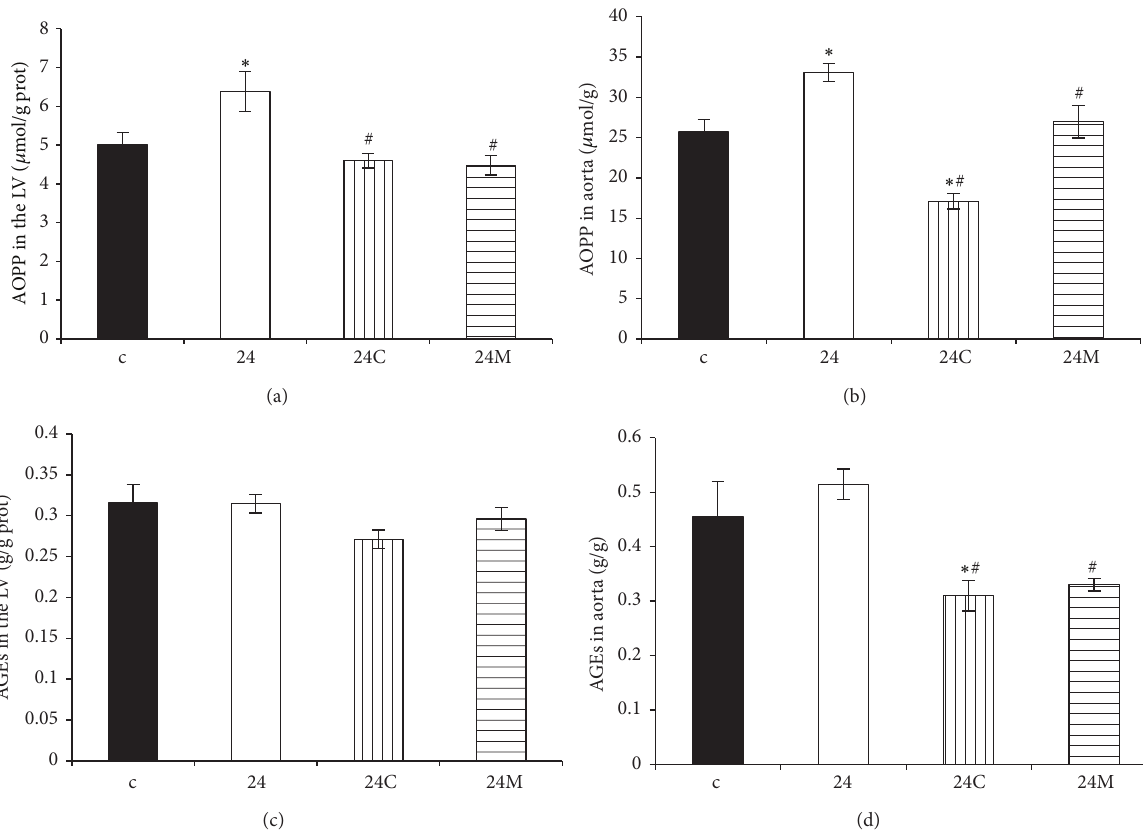
Figure 4: The influence of captopril (24C) and melatonin (24M) on advanced oxidation protein products (AOPP) in the LV (a) and aorta (b) and on advanced glycation end-products (AGEs) in the LV (c) and in the aorta (d) in 24 hours/day continuous light exposure-induced hypertension (24). c: Wistar controls. ∗ 𝑃 < 0.05 versus c; # 𝑃 < 0.05 versus 24. Table 2: The alpha- and gamma-tocopherol, oxidized coenzyme Q9 (CoQ9ox), and oxidized coenzyme Q10 (CoQ10ox) in control rats (c), rats exposed to 24 h/day light without treatment (24), and rats treated with captopril (24C) or melatonin (24M). Alpha-tocopherol in the LV Gamma-tocopherol in the LV CoQ9ox in the LV CoQ10ox in the LV (nmol/g) (nmol/g) (nmol/g) (nmol/g) c 58.8 ± 4.6 2.1 ± 0.4 248.2 ± 12.1 25.5 ± 2.3 24 50.6 ± 2.3 255.0 ± 21.5 25.0 ± 2.8 24C 49.9 ± 4.2 49.7 ± 2.8 26.8 ±